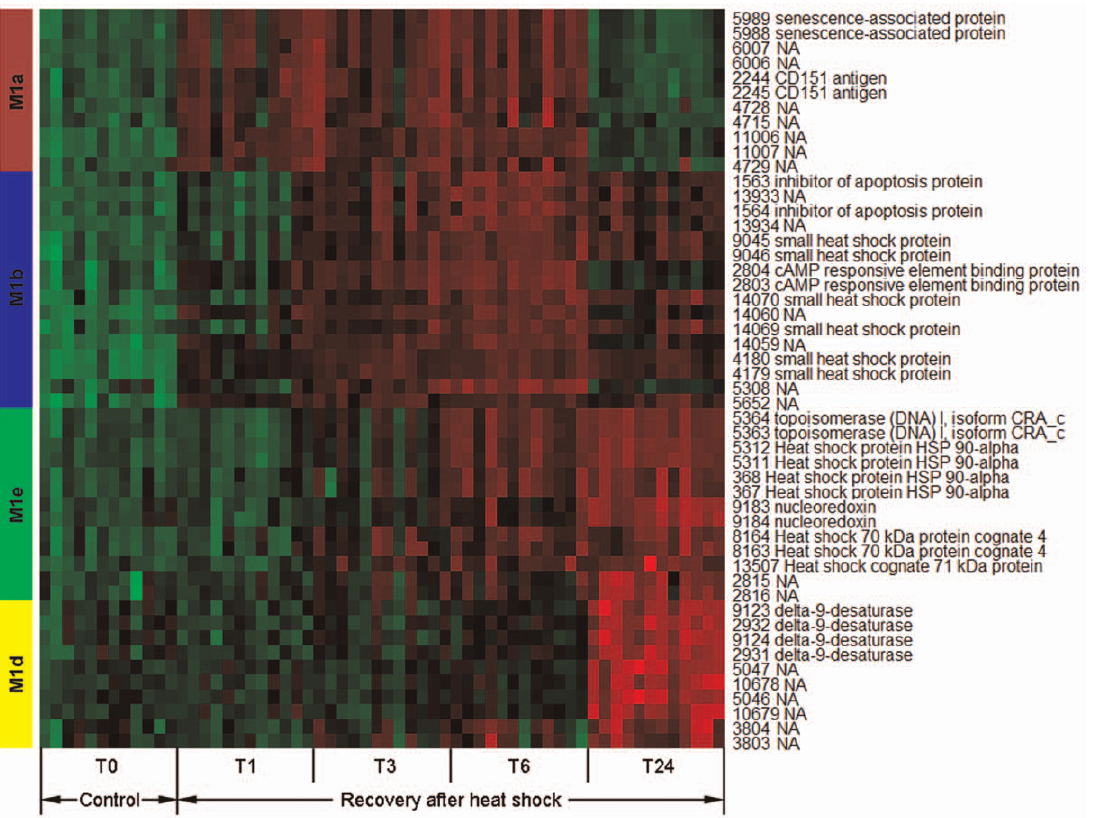
Figure 2. Heat map visualization of coexpression patterns of hub genes in submodules M1a, M1b, M1d and M1e. T0 represents an oyster control without heat treatment, whereas time points T1, T3, T6 and T24 represent recovery time (hour) after heat shock. Probe IDs and their associated gene annotations are shown on the right of the heat map. Red, up-regulation; Green, down-regulation.